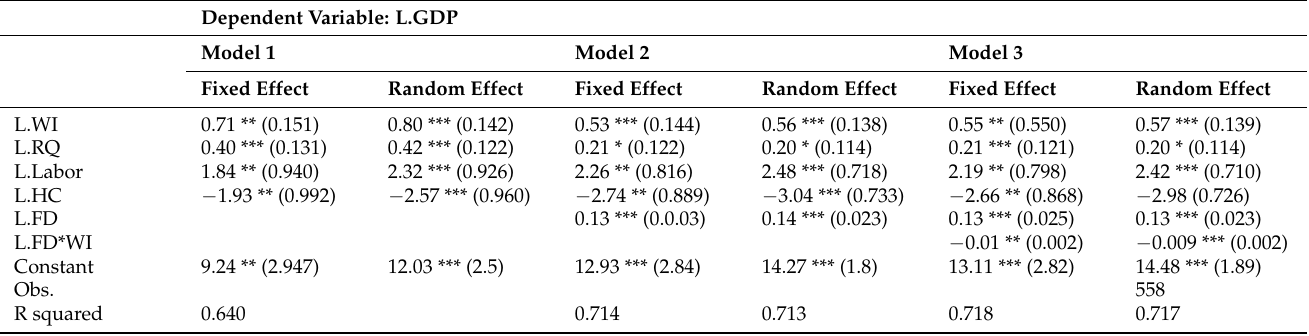
Table 5. Regression results of the economic impact of water infrastructure